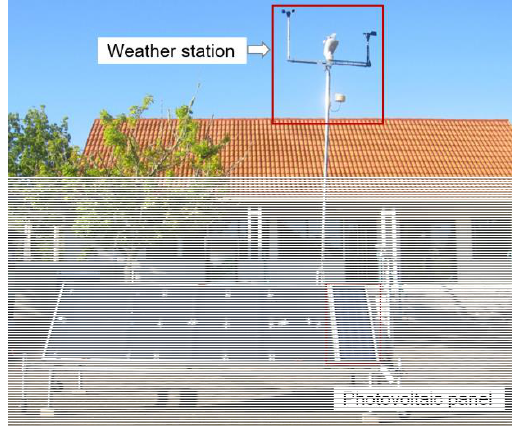
Figure 3. Setup of the experiment.